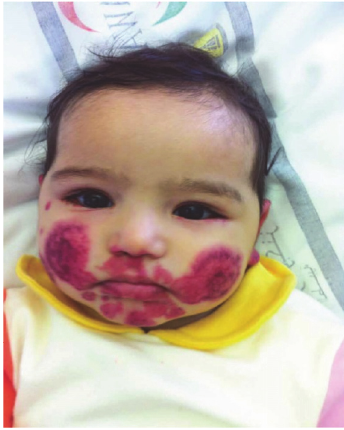
Figure 3: Day 2 after steroid treatment.